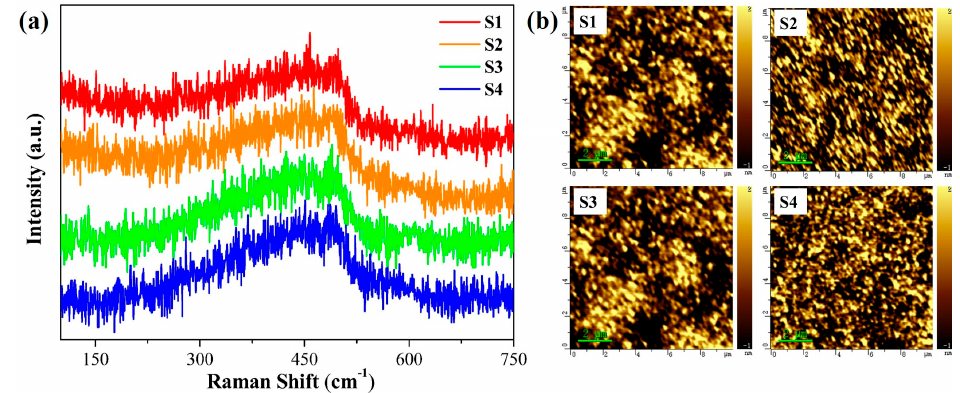
Figure 1. ( a ) Photoluminescence (PL) spectra of the SiCO:N films prepared by different NH 3 flow rates: S1 (0.5 sccm), S2 (1 sccm), S3 (3 sccm), and S4 (5 sccm). The inset is the optical images of PL from the films under 325 nm Xe lamp light excitation. ( b ) The optical band gap of the SiCO:N films vs. the NH 3 flow rates. The inset shows the (( α h ν ) 1/2 ·vs· h ν ) plot of the SiCO:N film S x (x = 1, 2, 3, 4).